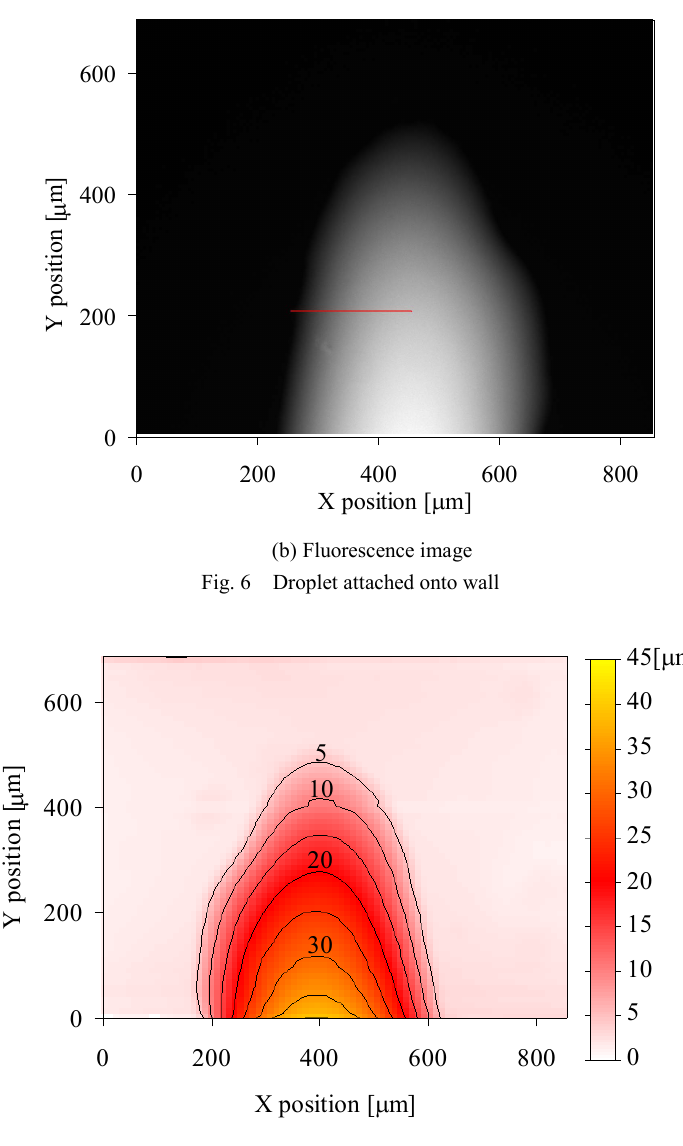
Fig. 7 Thickness of droplet on glass substrate measured by the present method